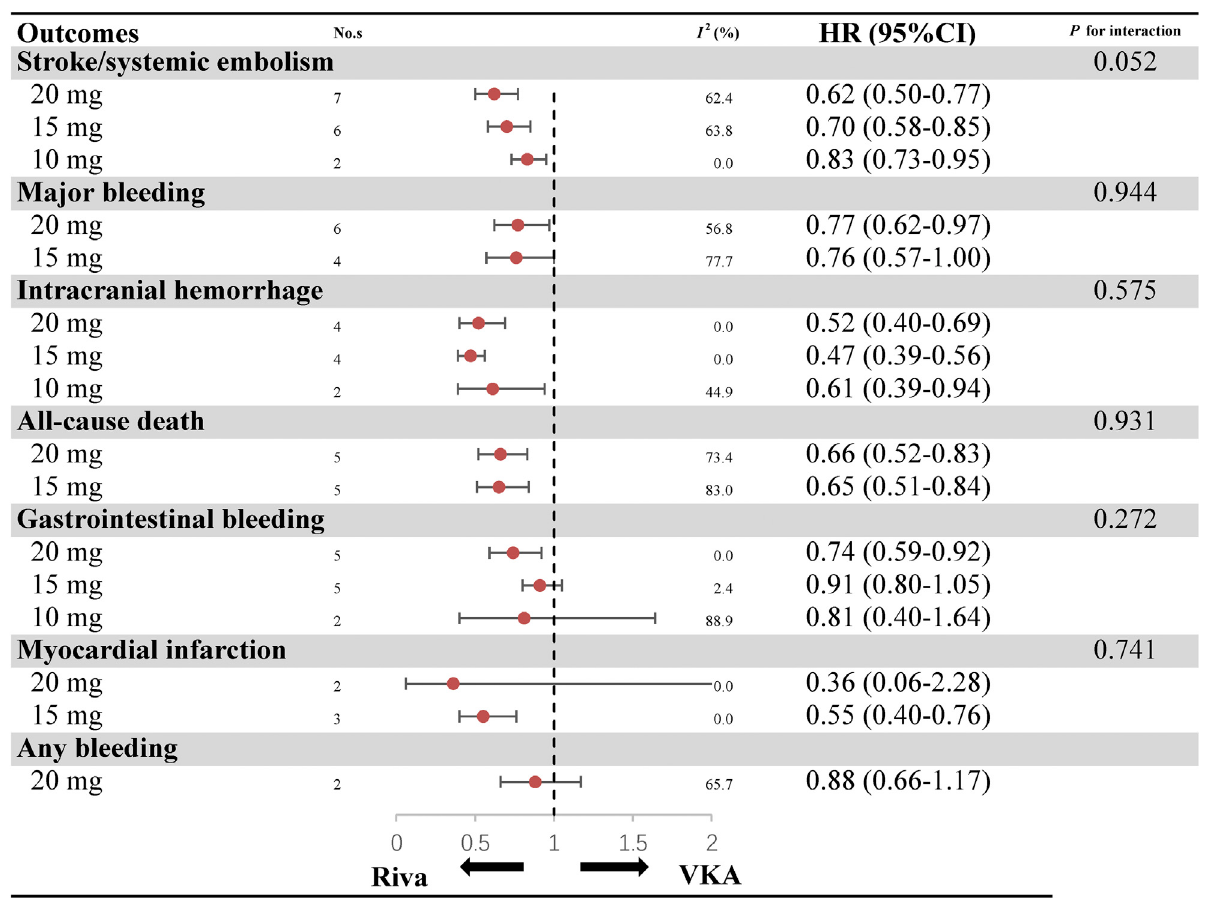
FIGURE 2 | Bene fi ts and harms of rivaroxaban by different dose